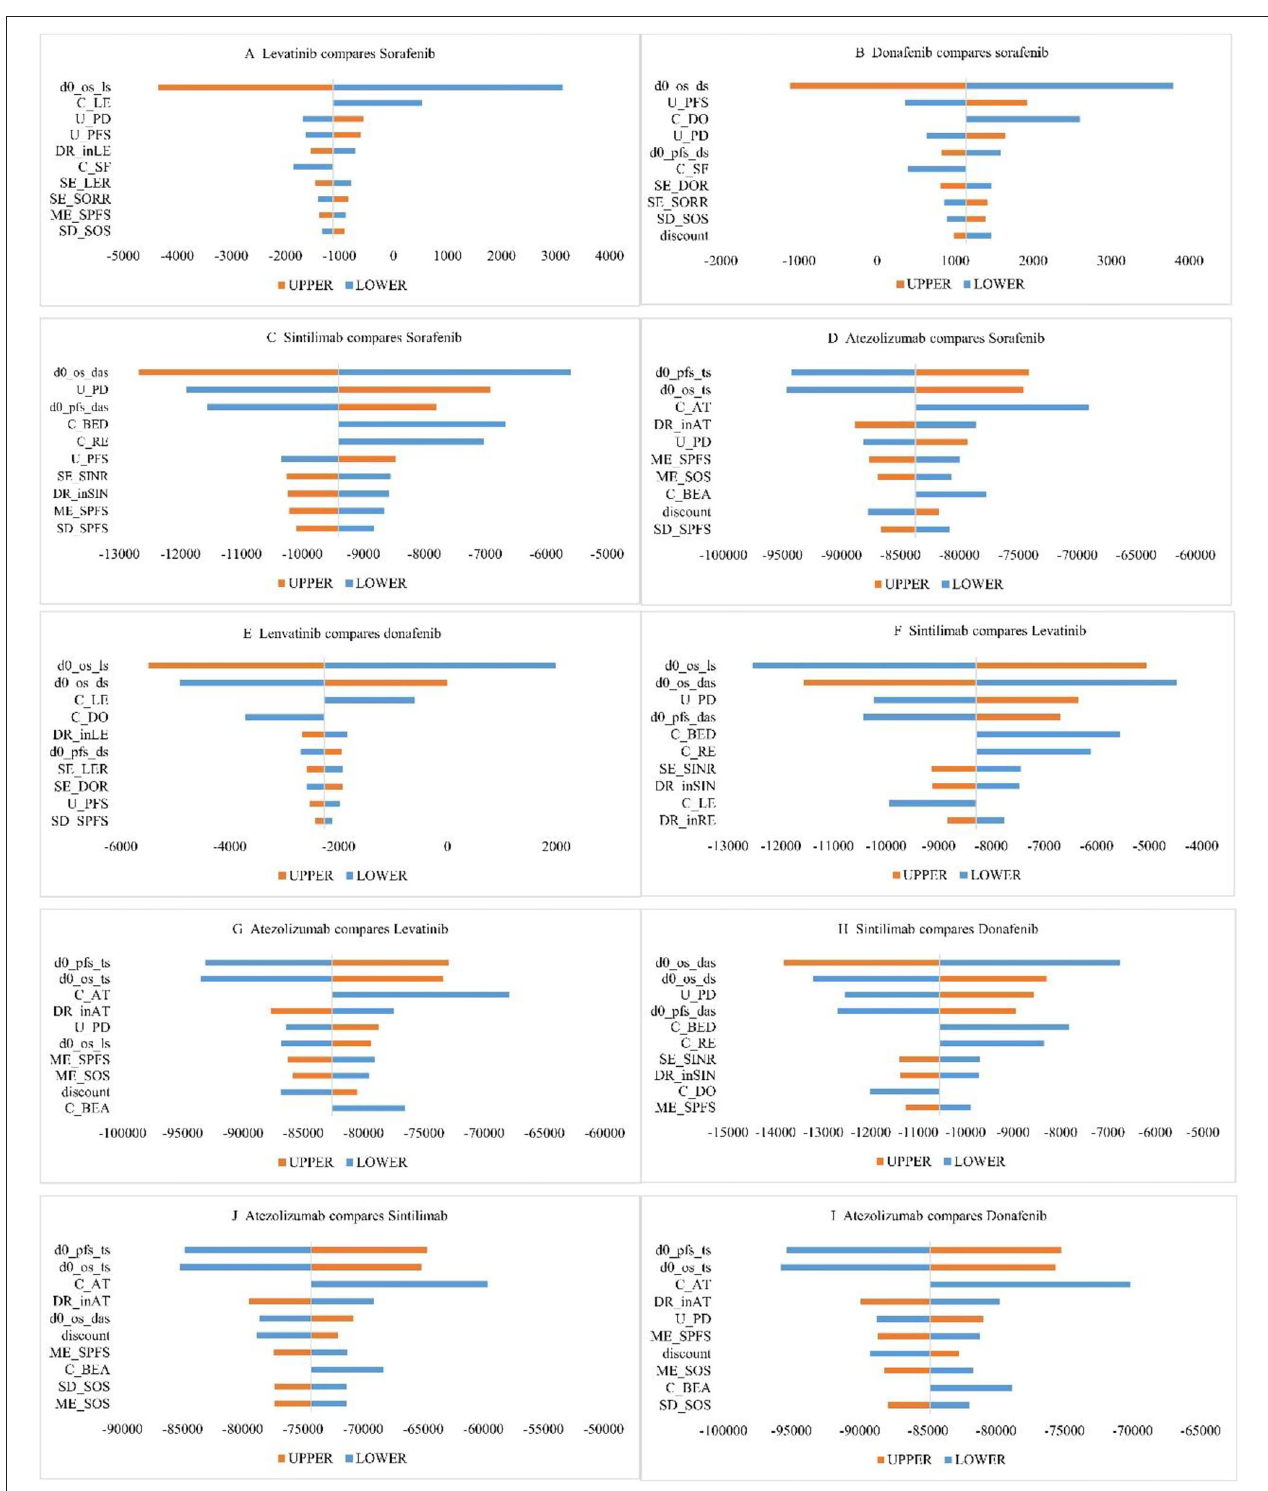
FIGURE 2 | One-way sensitivity analysis chart. (C_AT, unit price of atezolizumab; C_BED, unit price of bevacizumab (D + A group); C_BEA, unit price of bevacizumab (T + A group); C_DO, unit price of donafenib; C_LE, unit price of lenvatinib; C_RE, unit price of regorafenib; C_SF, unit price of sorafenib; DR_inAT, dosage density of T + A; DR_inLE, dosage density of lenvatinib; DR_inSIN, dosage density of D + A; d0_os_das, OS HR (D + A vs sorafenib); d0_os_ds, OS HR (donafenib vs sorafenib);d0_os_ls, OS HR (lenvatinib vs sorafenib); d0_os_ts, OS HR (T + A vs sorafenib); d0_pfs_das, PFS HR (D + A vs sorafenib); d0_pfs_ds, PFS HR